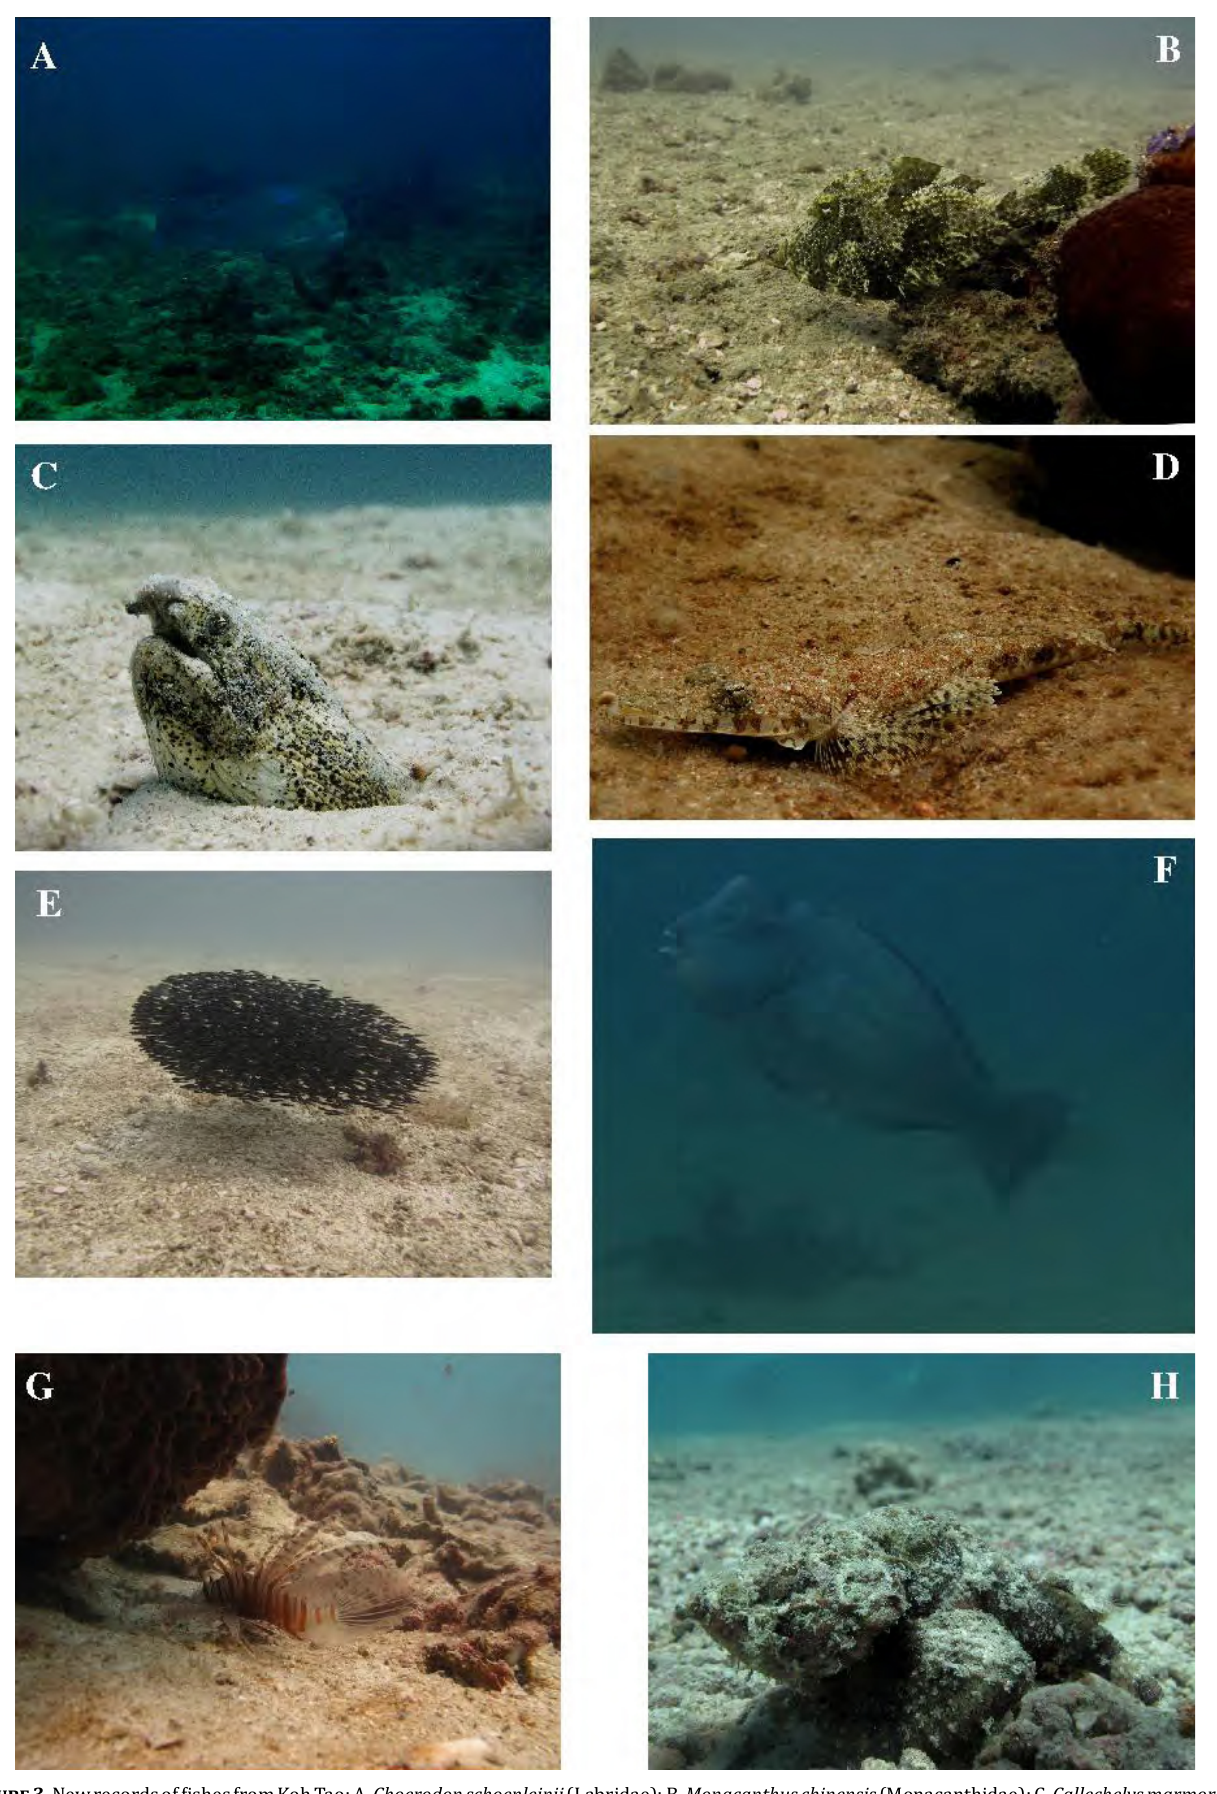
Choerodon schoenleinii Monacanthus chinensis Callechelys marmorata Thysanophrys chiltonae (Labridae); B, (Monacanthidae); C, Bolbometopon muricatum, Pterois russelii cf. (Platycephalidae) lying on sandy bottom; E, juveniles of solitary adult (Scaridae); G, (Scorpaenidae);